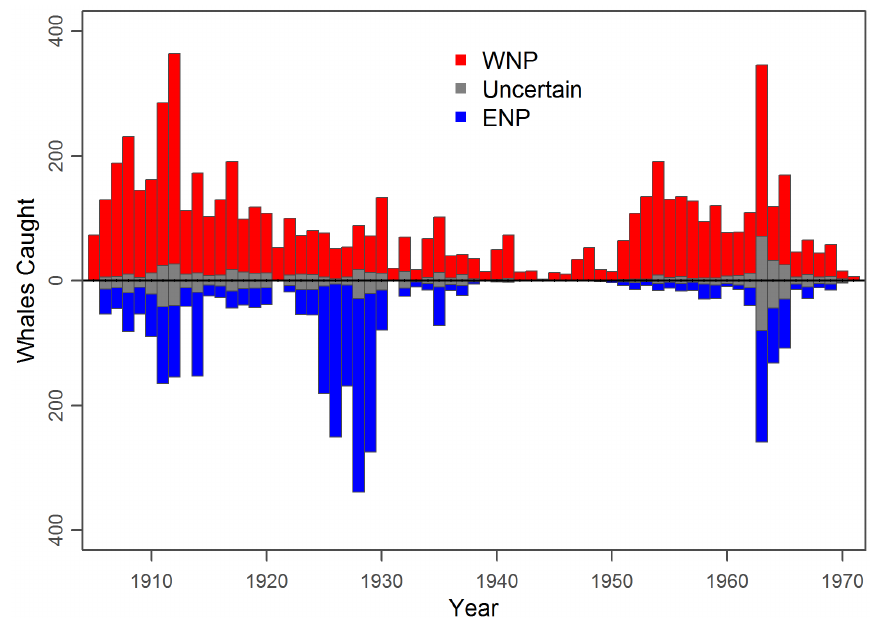
Figure 11. Estimated annual catches of ENP and WNP blue whales for the base case. Grey values contain 95% of the population uncertainty, and if above the line are more likely to be WNP, below the line more likely to be ENP. The uncertainty in the 1960s is caused by the unreported Soviet catches with high location uncertainty.